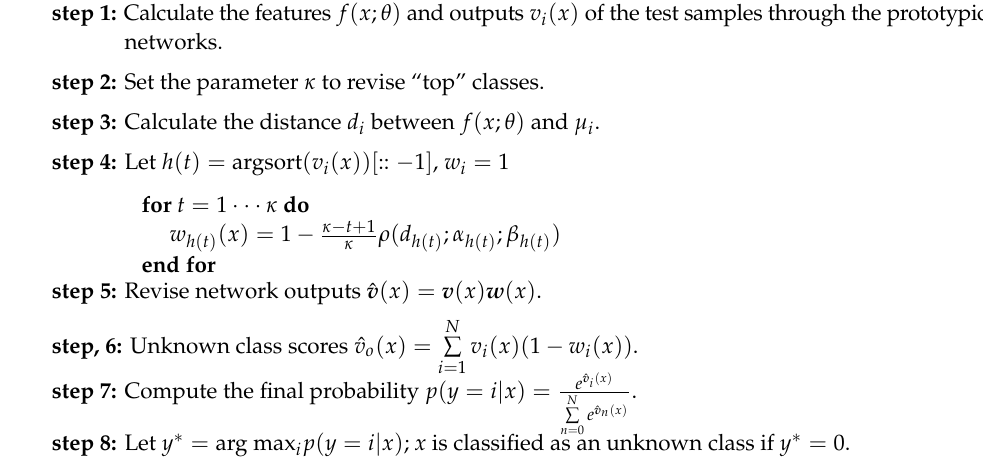
Algorithm 2 Testing and